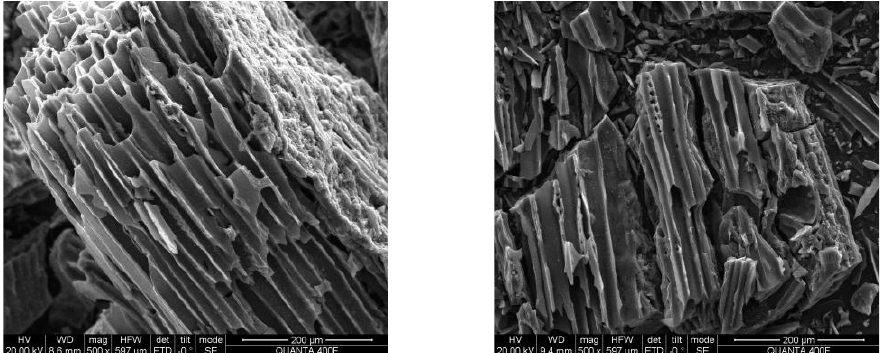
Figure 2. The SEM micrographs of GAC ( left ) and MGAC ( right ).